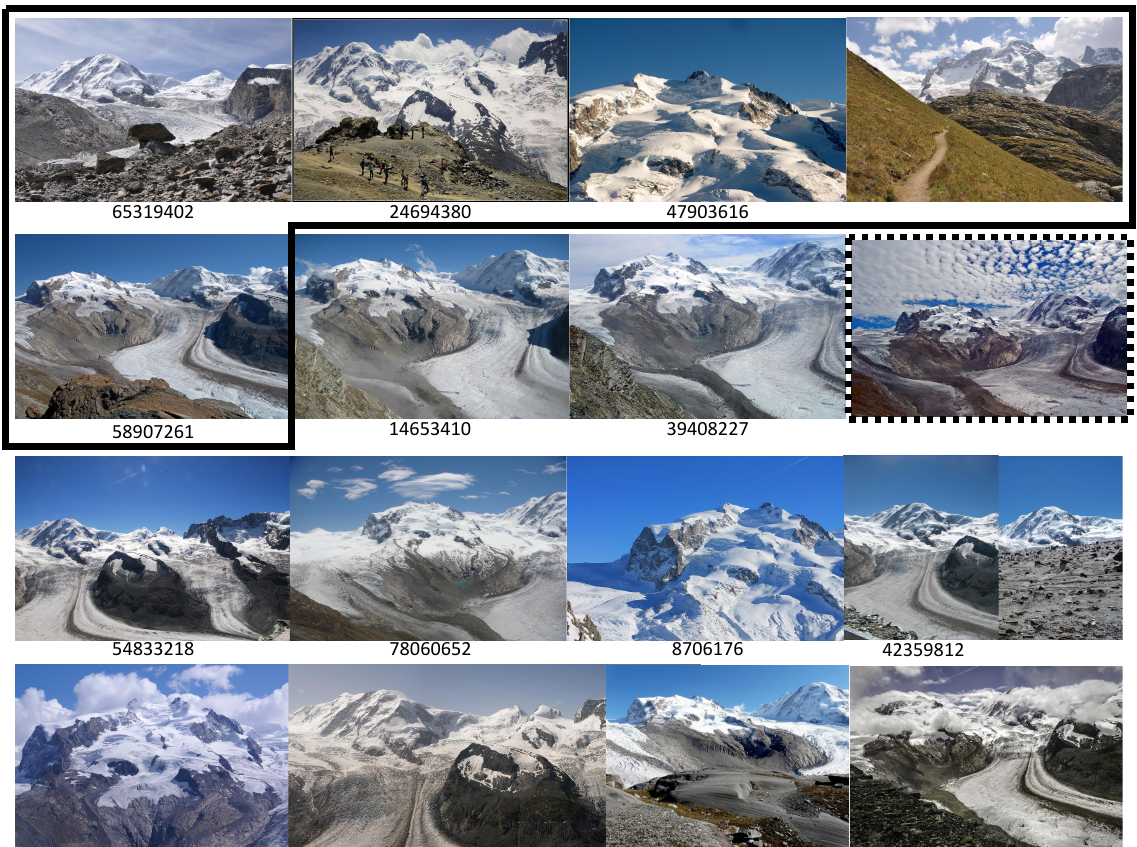
Figure 6: Images used to compute statistics in Tables 1 and 2. GPS images are within the box, numbers correspond to the ones within the tables. Thei Image within the dashed box, is used for the statistic in Table 3 Unlabelled images are randomly selected within the